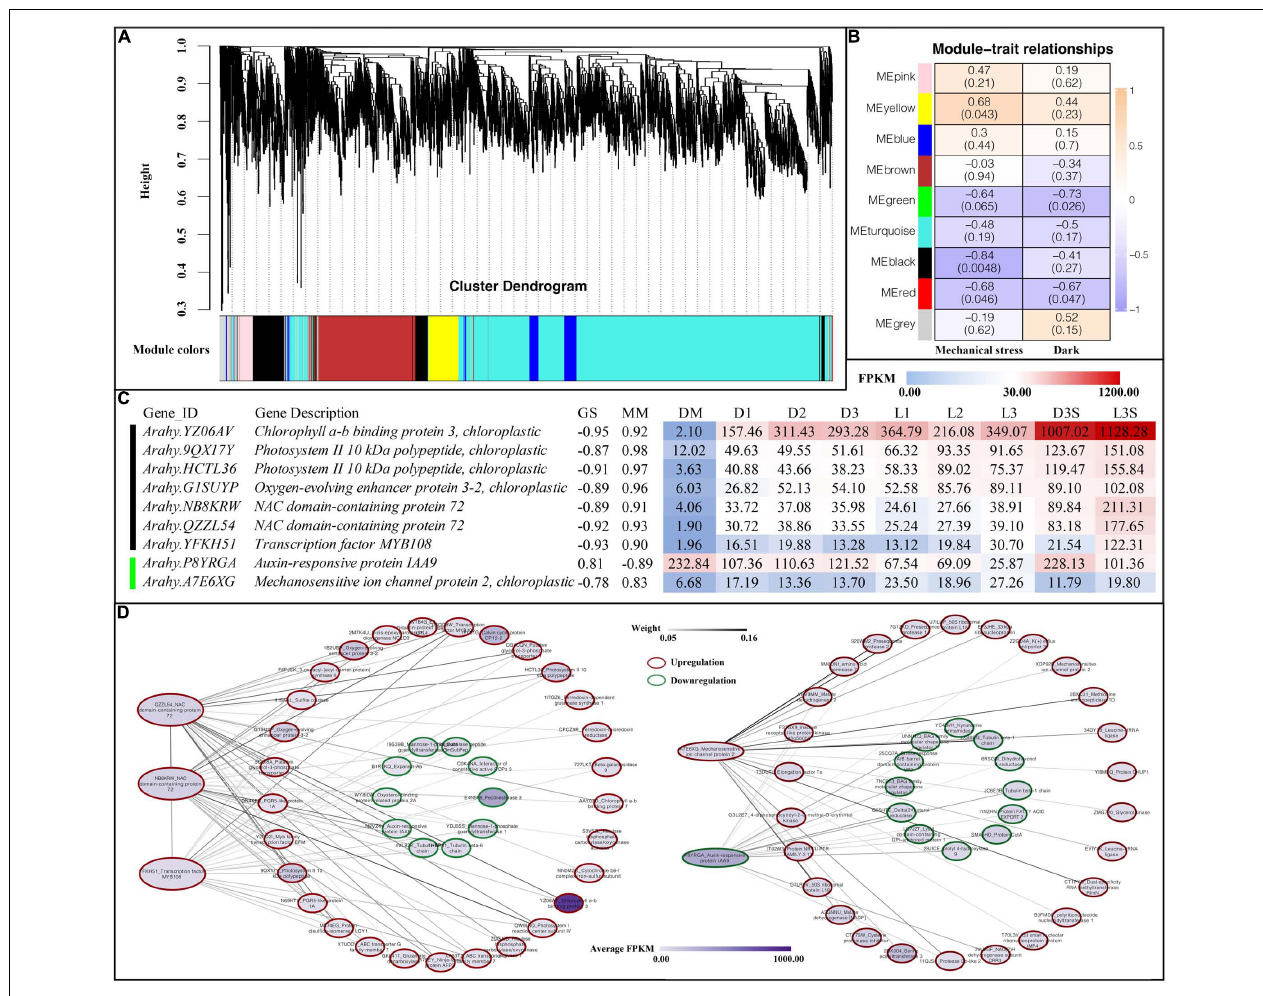
FIGURE 6 | Weighted gene co-expression network analysis. (A) Cluster dendrogram for module construction; (B) module-trait relationships inside the cell; the number above represents the correlation coefficient, and the number in parentheses below represents significance; (C) hub gene of black and green modules, GS, gene significance; MM, module membership; (D) co-expression network of hub